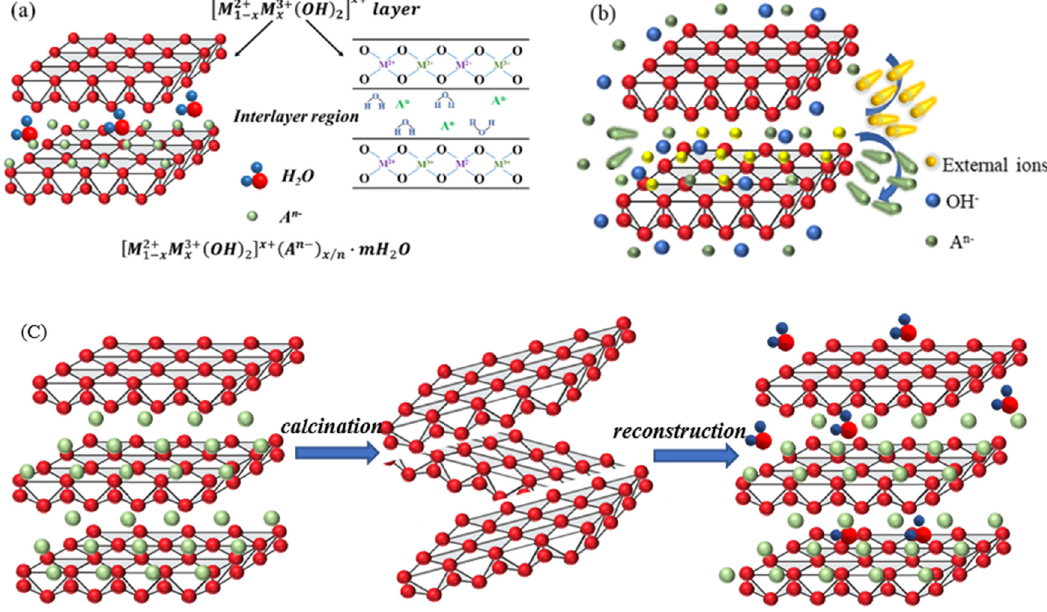
Figure 2: Schematic diagram of a typical structure of LDHs: ( a ) basic structure, ( b ) ion exchange of LDHs, and ( c ) calcination and structure reconstruction of